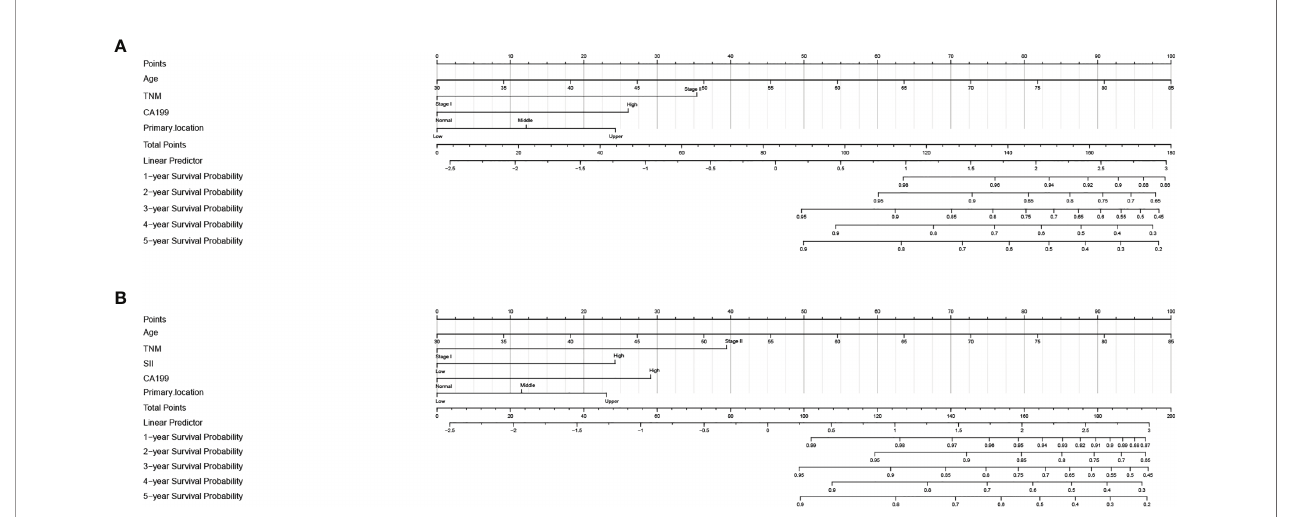
FIGURE 7 | Nomogram for 1 – 5-year overall survival in stage I – II GC. (A) Conventional nomogram with signi fi cant clinical factors. (B) SII-based survival nomogram with SII and signi fi cant clinical factors. SII, systemic immune-in fl ammation index; CA19-9, carbohydrate associated antigen 19-9.